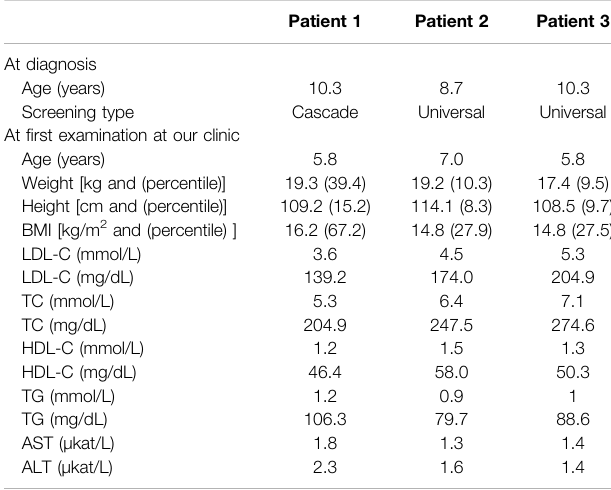
TABLE 2 | Demographical and clinical characteristics of the LAL-D positive